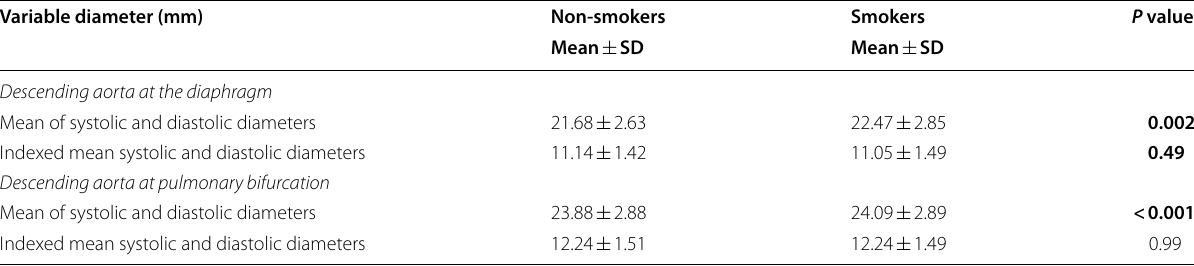
Table 24 Comparison of descending thoracic aorta diameters in smokers and non‑smokers